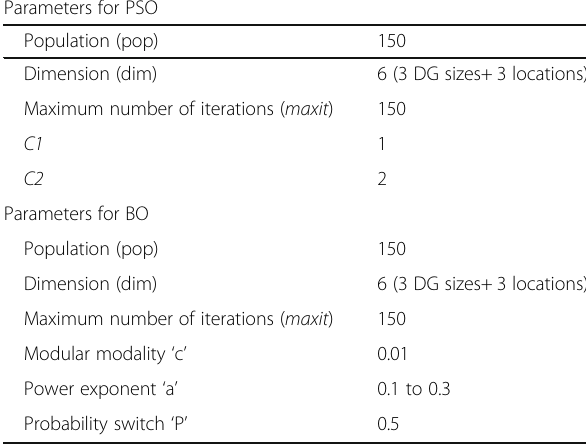
Table 3 Parameters description of PSO and BO